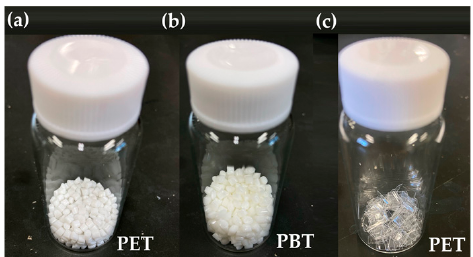
Figure 3. Samples for commercially available ( a ) poly(ethylene terephthalate) (PET), ( b ) poly(butylene phthalate) (PBT) pellets, and ( c ) PET sheets by cutting the drink PET bottle.